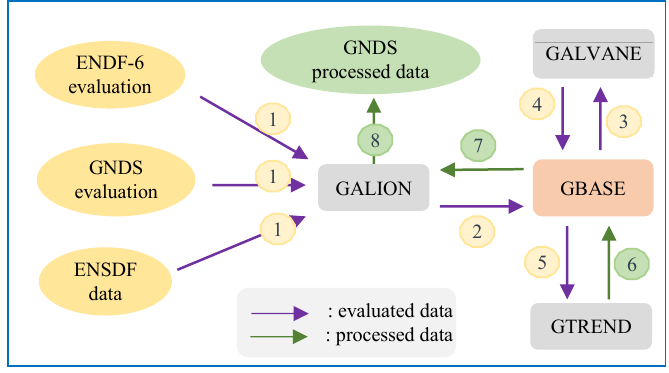
Fig. 1. GALILÉE-1 processing modules